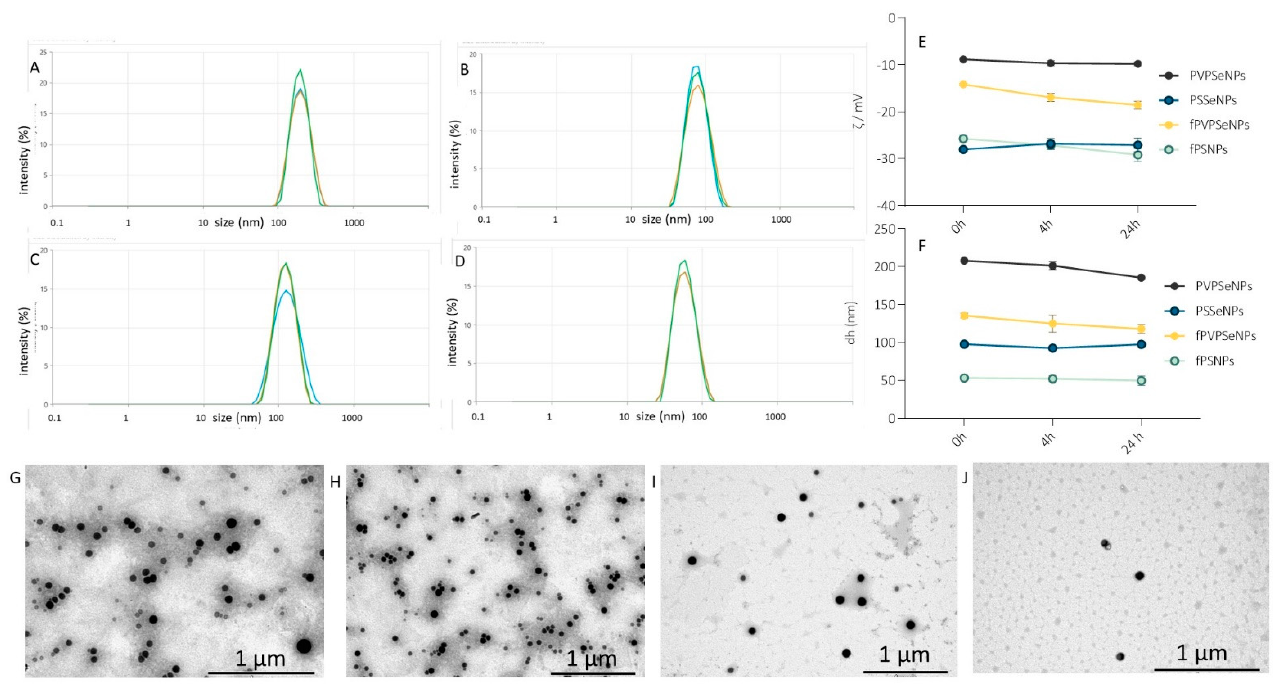
Figure 3. Size distribution by intensity. Stability and transmission electron microscopy (TEM) images of SeNPs: size distribution of PVPSeNP ( A ), PSSeNPs ( B ), fPVPSeNPs ( C ) and fPSSeNPs ( D ); 24h stability of zeta potential of NPs ( E ); 24h stability of an average diameter of NPs ( F ); TEM images of PVPSeNP ( G ), PSSeNPs ( H ), fPVPSeNPs ( I ) and fPSSeNPs ( J ). PVPSeNPs—selenium nanoparticles coated with polyvinylpyrrolidone; fPVPSeNPs—selenium nanoparticles coated with polyvinylpyrrolidone and functionalized with olive pomace extract; PSSeNPs—selenium nanoparticles coated with polysorbate; fPSSeNPs—selenium nanoparticles coated with polysorbate and functionalized with olive pomace extract.